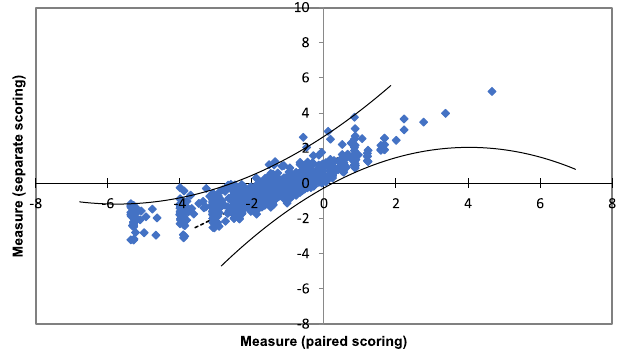
FIG. 10. Cross-plot of persons measures when the test was scored with a separate and paired model. The black lines in the plot represent 95% confidence intervals. there are still some advantages and disadvantages of each model. The advantages of the separate scoring model are a larger number of items, a better targeting on the sample, nation of answers on the first and second tier, obtained through separate scoring, give an insight into the most common student difficulties. Disadvantages of the separate scoring model are the reward of possible guesses and a high dependency of the items. In contrast, paired scoring strongly reduces guessing, but the number of items is significantly reduced and some information may be lost.